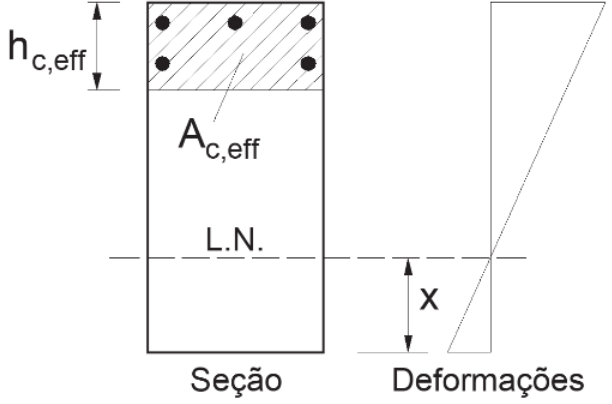
para o cálculo c,eff